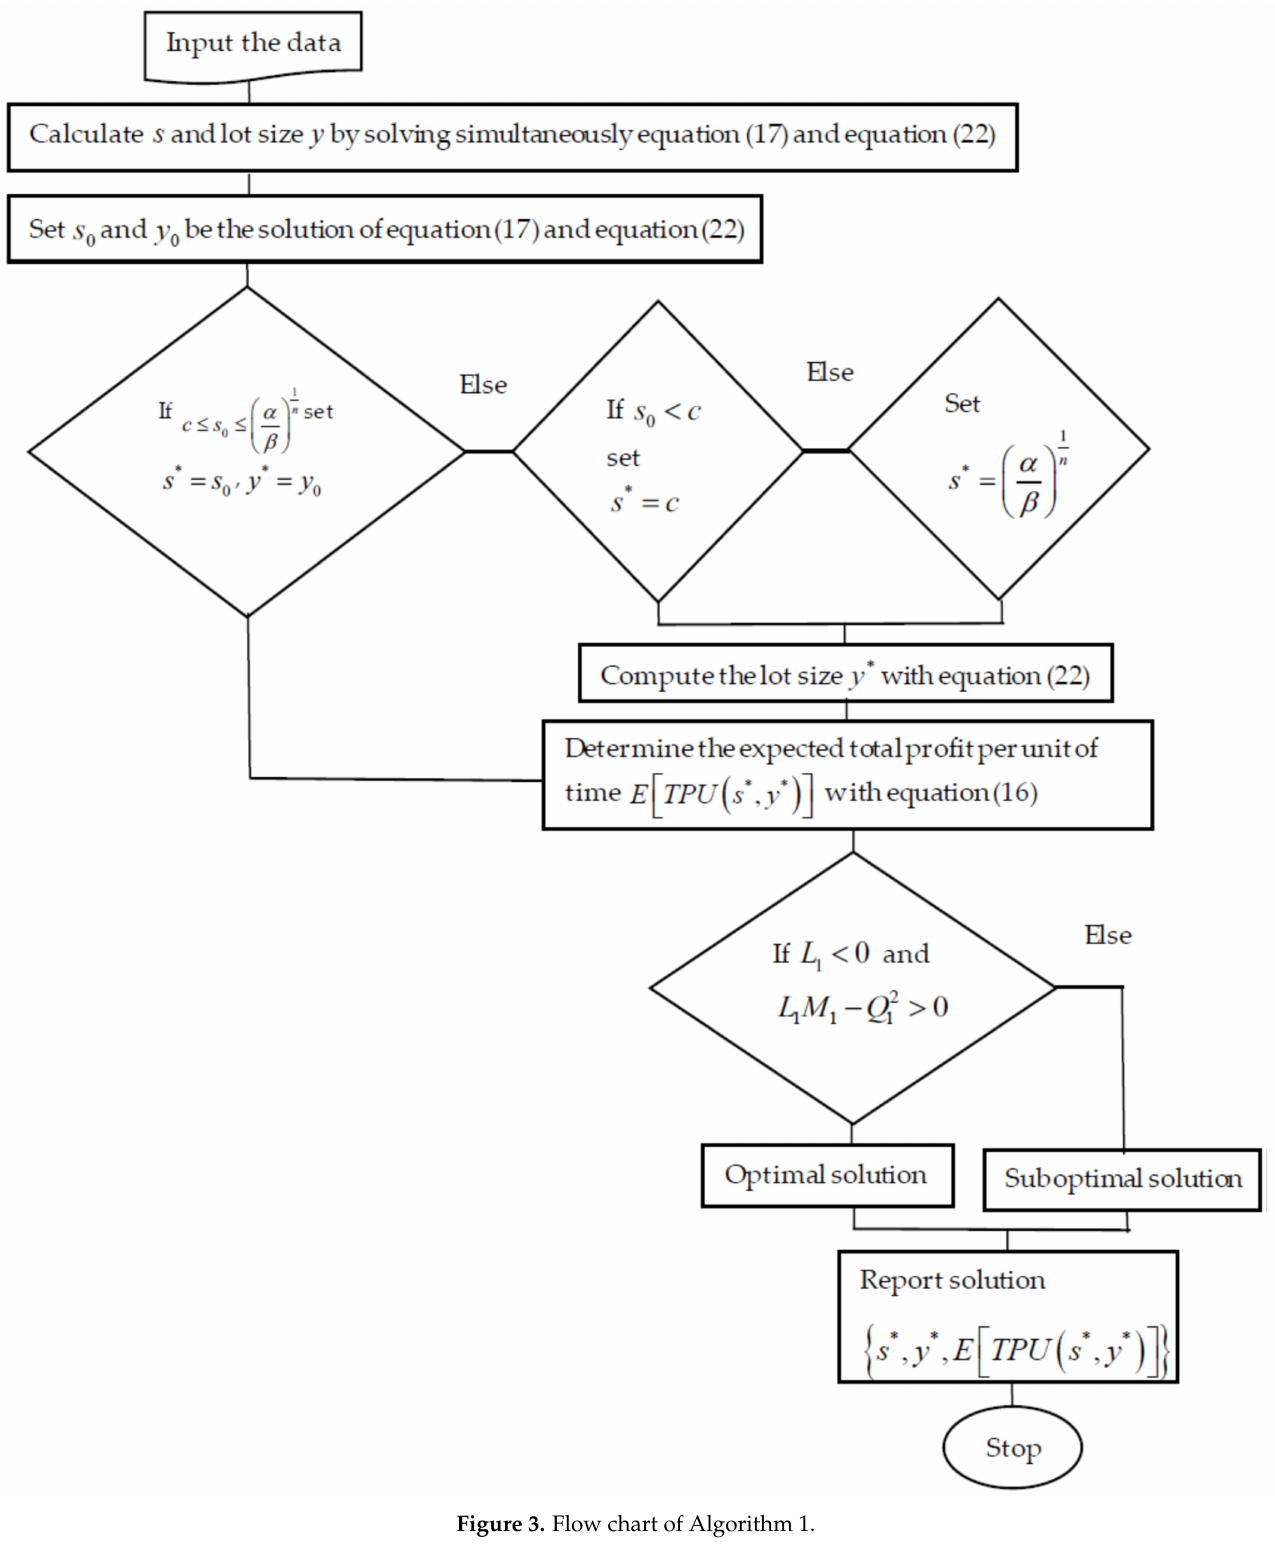
Figure 3. Flow chart of Algorithm